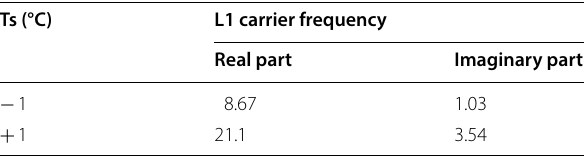
The soil temperature is changed from